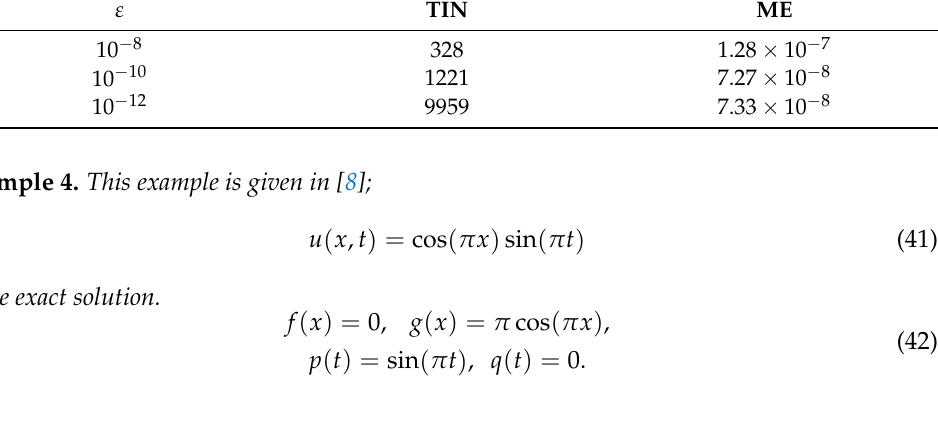
Figure 9. For Example 4: ME( u ) versus x at 𝑡𝑡 𝑓𝑓 = 0.5. 5. Numerical Method for Backward Nonlocal Wave Problem We consider the backward nonlocal wave problem and replace Equation (2) by the final time conditions: